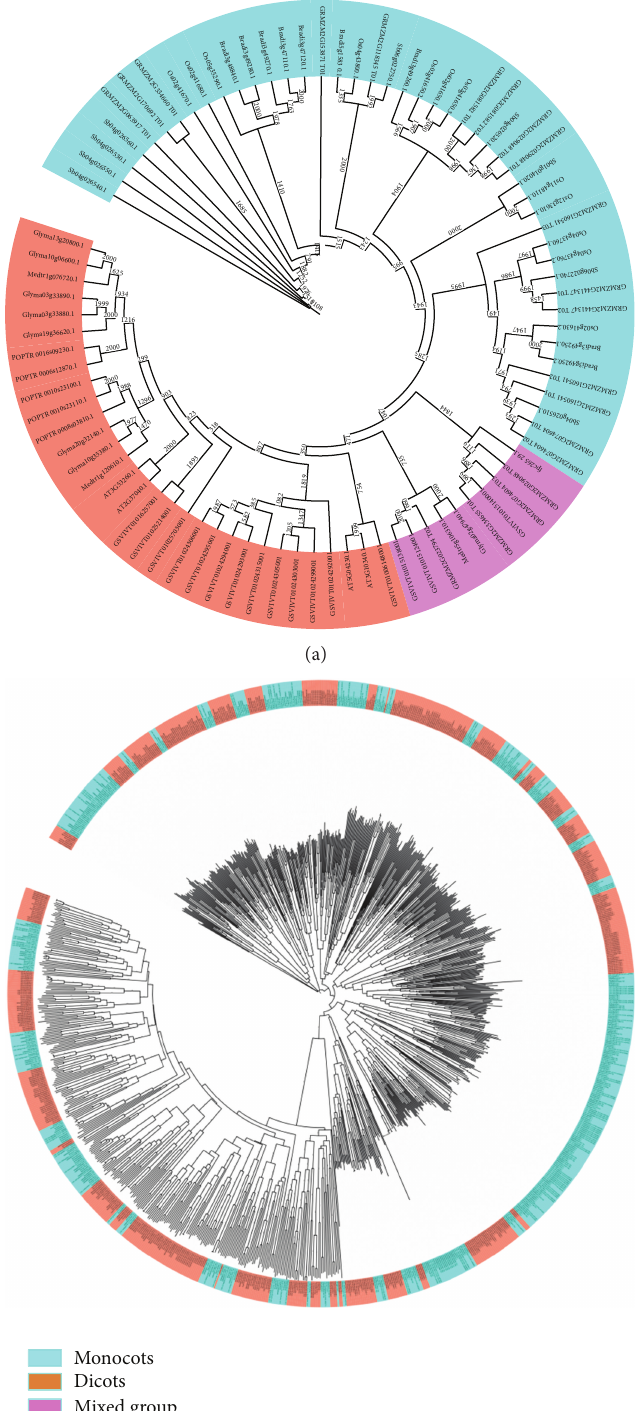
Figure 5: Phylogenetic tree of the (a) PAL family and the (b) POX A family. Amino acid sequences were aligned with ClustalW and NJ tree constructed using the ClustalX 2.1 and interactively designed with iTOL. Bootstrap values are assigned above the branches. Orange and sky blue indicate dicot and monocot clusters, respectively, whereas a pink one indicates a mixed cluster found only with